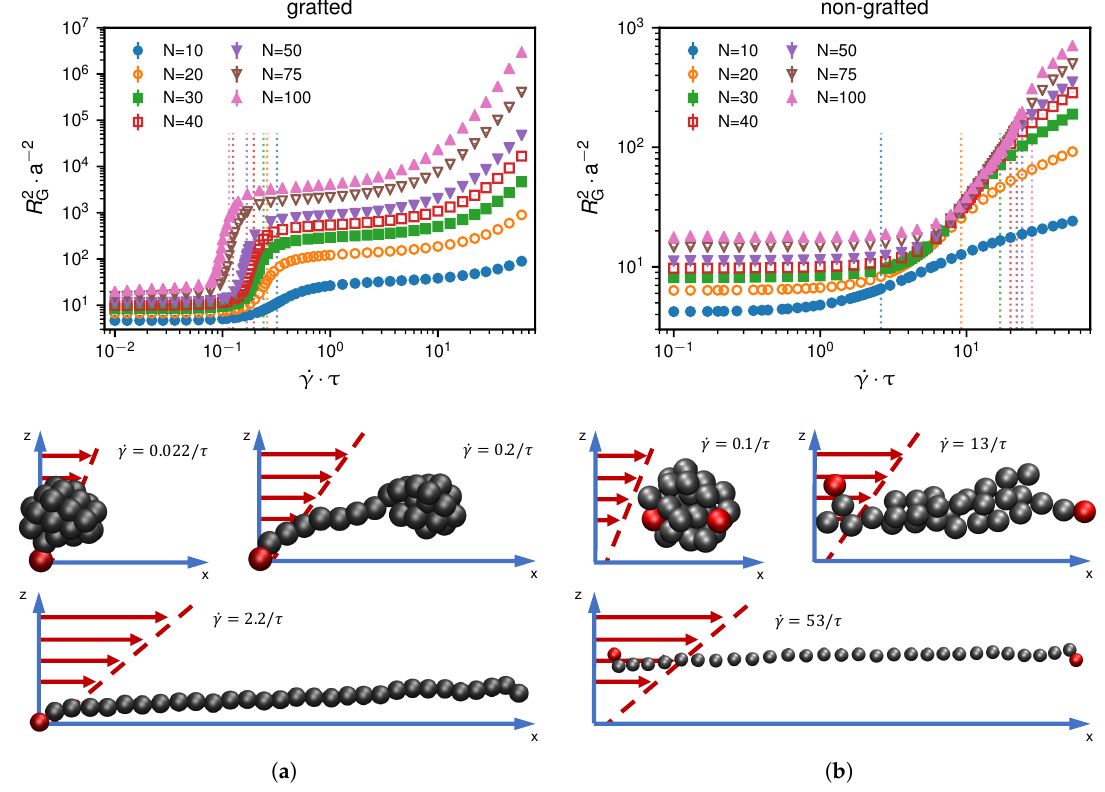
Figure 2. An increase of the shear rate ˙ γ above a certain threshold, which depends on the size of the chain, initiates a transition from a collapsed to a coiled or extended state. The vertical dashed lines relate to the steepest increase of the mean-squared radius of gyration as a function of the shear rate. We present results for different monomer numbers N . Subfigures ( a , b ) show the grafted and non-grafted cases, respectively. We also show simulation snapshots for N = 30 below, at and above the critical shear rate of ˙ γ ∗ = 0.24 τ − 1 for the grafted and ˙ γ ∗ = 13 τ − 1 for the non-grafted scenario.